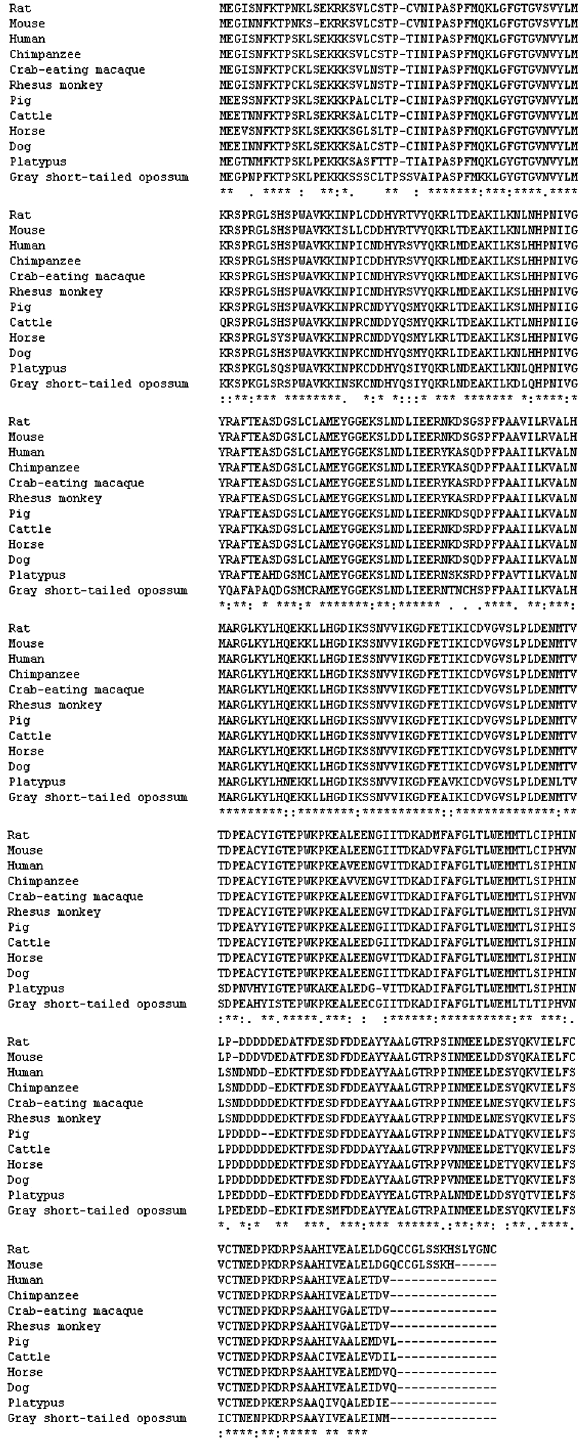
Figure 4 - The alignment of the twelve kinds of PBK proteins.